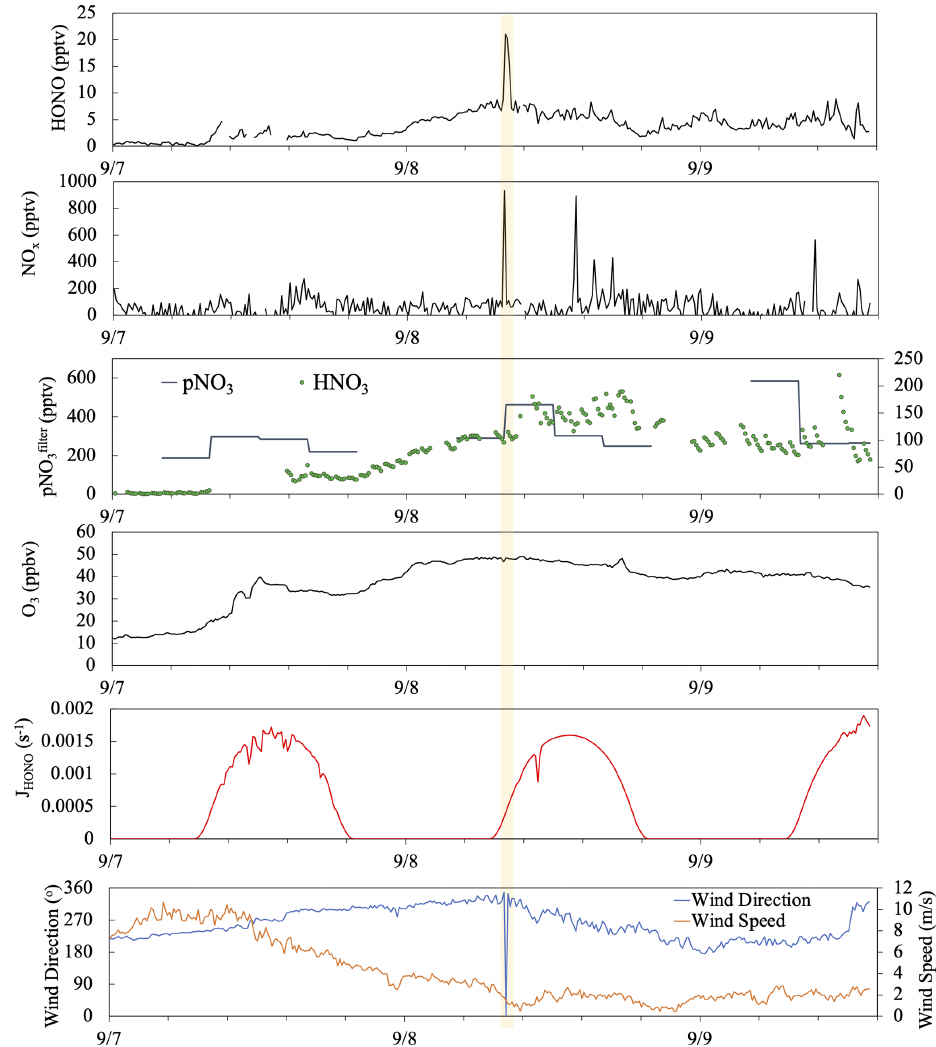
, HNO 3 , O 3 , HONO photolysis rate constant ( J HONO ), wind direction, and wind 3